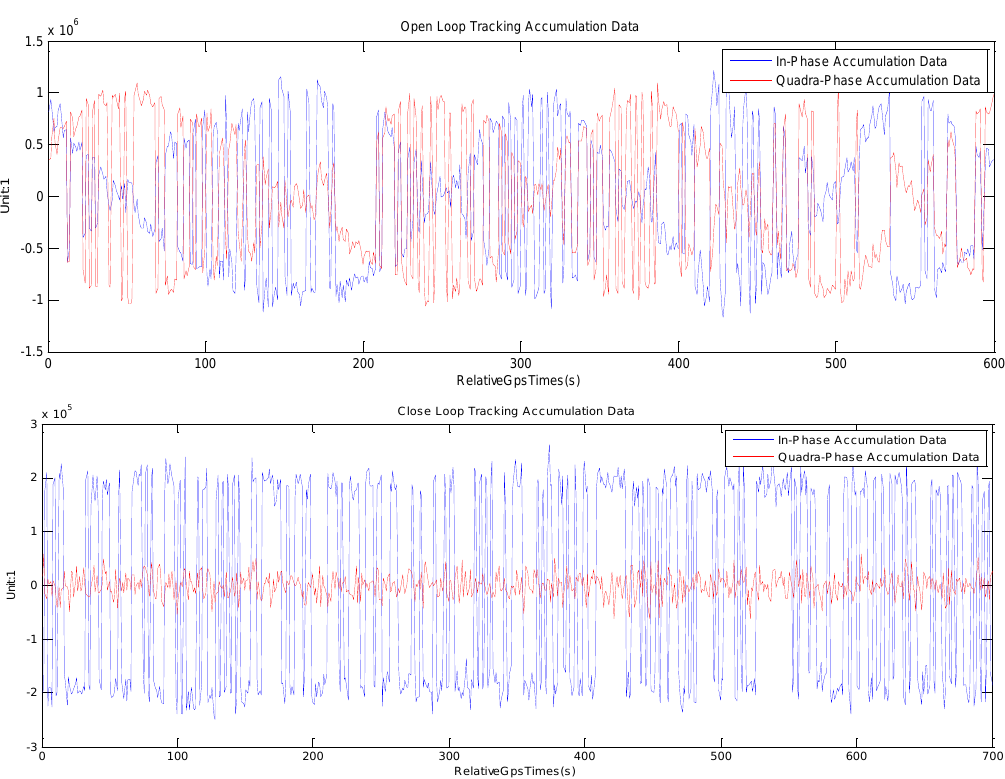
Figure 5. Real-time results of open-loop (OL) / closed-loop signal components of In-Phase (I, in blue line) and Quadra-Phase (Q, in red line). The abscissa is relative time in second, and the ordinate represents the components’ value. The top plane shows the characteristics of OL tracking mode that extreme values alternately appear in I and Q components; the bottom plane shows the characteristics of the closed-loop tracking mode that extreme values appeared in the I component.